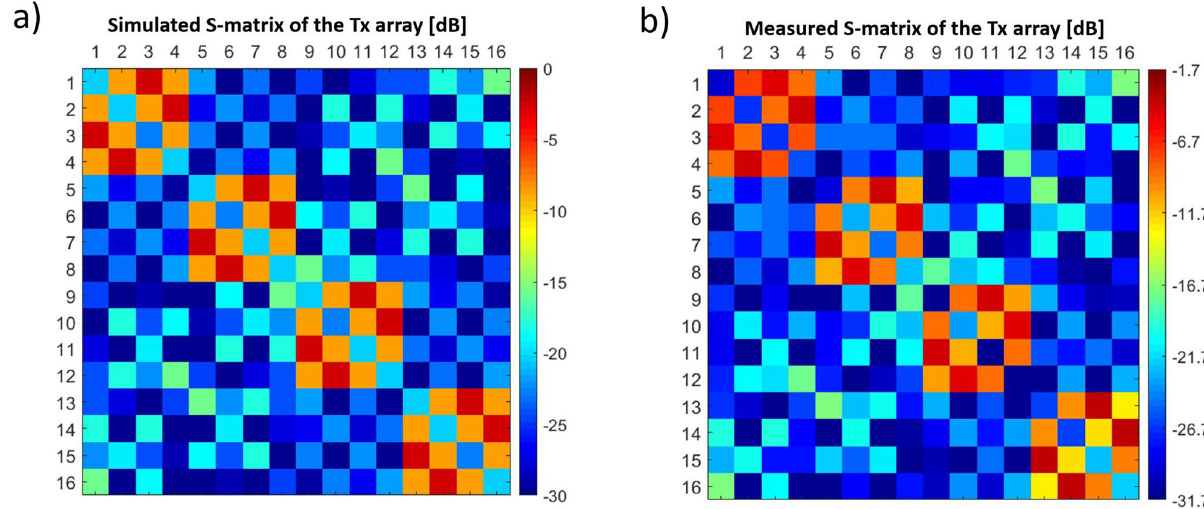
Figure 2. S-parameter comparison between simulations and experiments of the Tic Tac Toe 16-channel Tx head coil. In ( a ), the FDTD simulated s-matrix using a transmission line model mechanism; in ( b ), the experimentally measured s-matrix of the constructed head coil. The color scale limits were modified to compensate for the electrical losses in the constructed coil (not included in FDTD